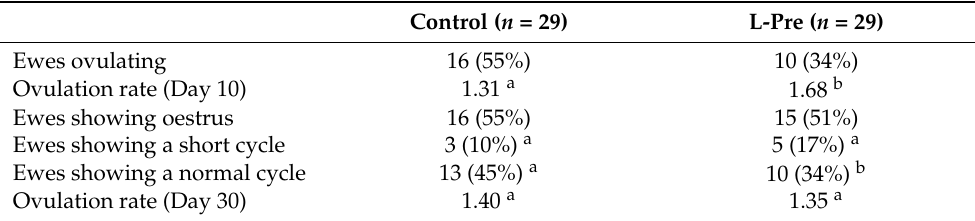
Table 2. Reproductive variables in Merino ewes induced to ovulate using the “male effect” during the anoestrus season. Ovulation data were collected at laparoscopy on Day 10 and Day 30. Different superscripts indicate significant differences ( p <